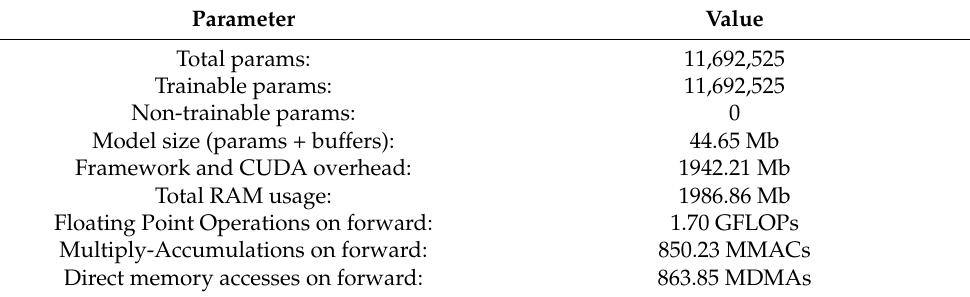
Figure 10. Time performance of the proposed network model on the ItalianPVS and Lithuanian voice datasets. Table 2. Size of the U-lossian